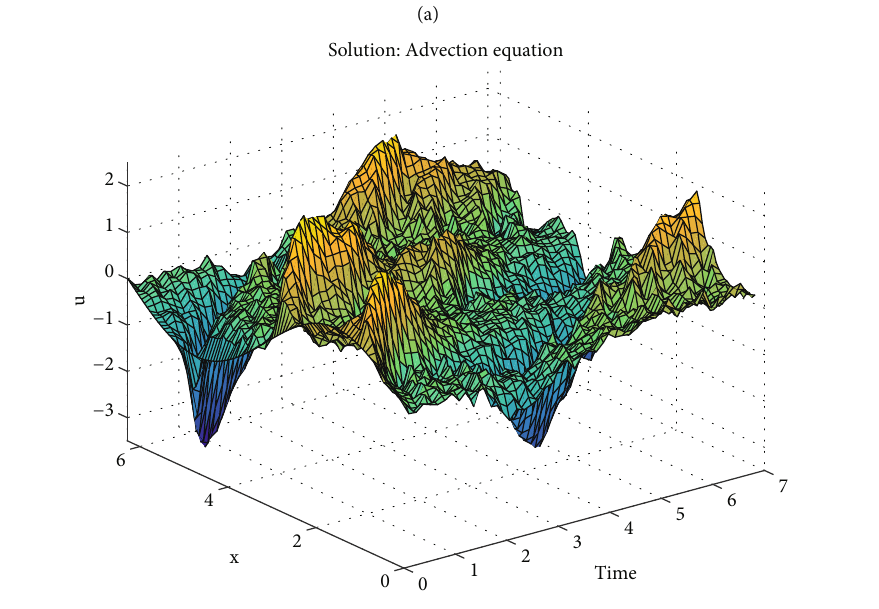
Figure 1: Contour and surface plots for a single realisation of the stochastic advection equation under the following setting: L = 2 π , N = 100 , δ x = L / N , δ t = 0 : 007 , T = 1000 , σ = 0 : 1 , μ = 0 : 01 , C ð x Þ = e λ ð x Þ where λ ð x Þ = sin ð 2 π x Þ , and u